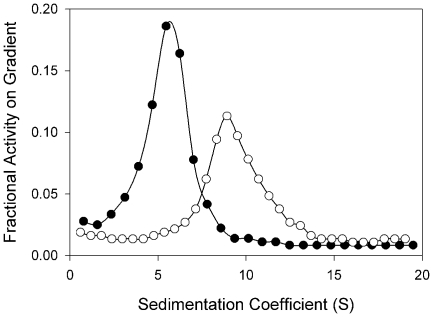
Velocity sedimentation analysis of the molecular forms of recombinant O. latipes BChE.HIS extracts from COS-7 cells transfected with cDNA for BChE were sedimented on gradients prepared in presence (•) and absence (○) of Triton X-100 as described in Materials and Methods. Data are presented as the fraction of total BChE activity on the gradient as a function of sedimentation coefficient.